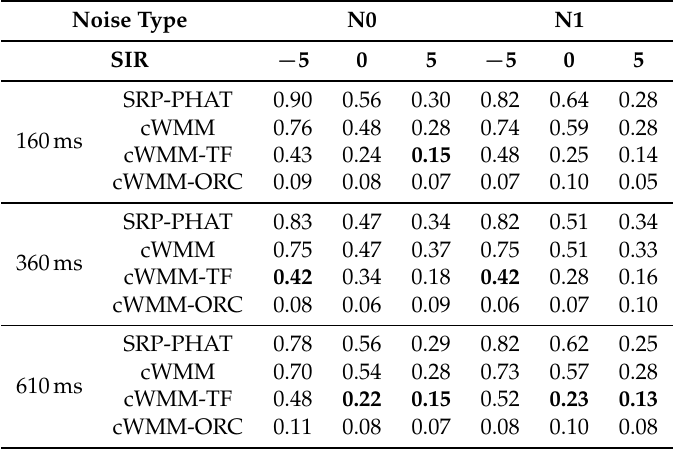
Table 1. The GER (100%) of the algorithms in different test environments with competing speakers. The bold numbers indicate the best results excluding cWMM-ORC for each SIR. TF, Time-Frequency; ORC,